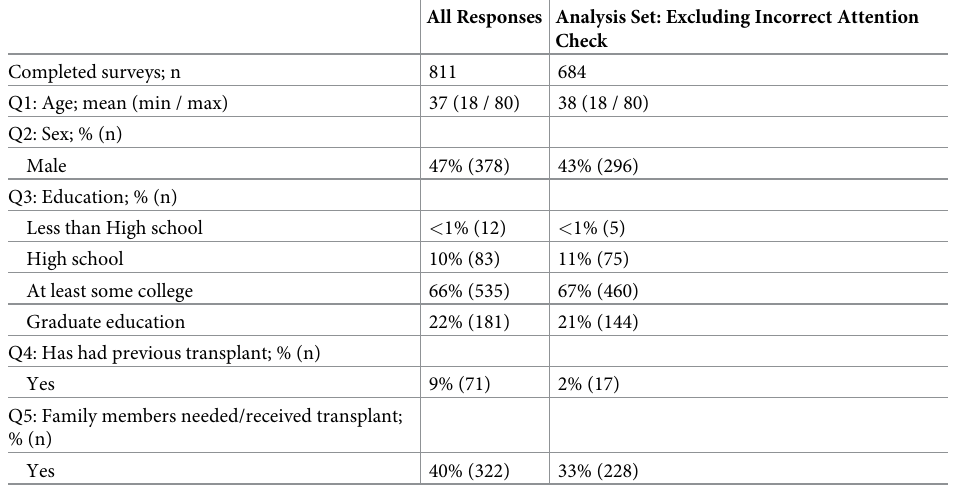
Table 1. Characteristics of participants who completed the survey (Questions #1-#5) � . All Responses Analysis Set: Excluding Incorrect Attention Check